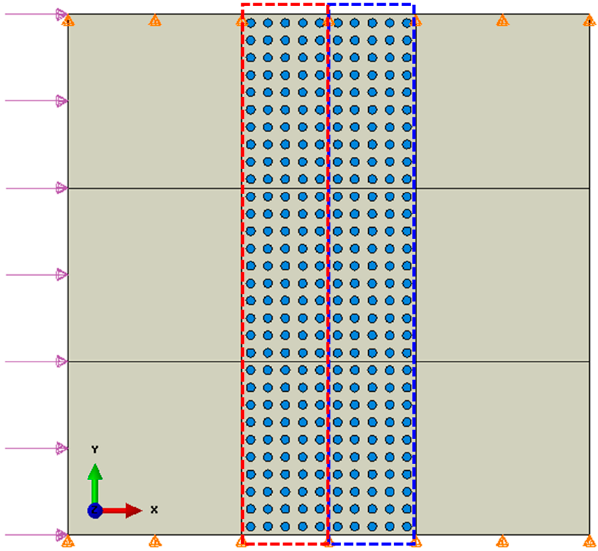
Figure 10. Numerical model of the composite with two different local natural frequencies: 𝑓 (cid:2868) (cid:3406) f 0 ≈ 0.3 MHz for the particles in the red rectangular box and f 0 ≈ 0.6 MHz for the particles in 0.3 MHz for the particles in the red rectangular box and 𝑓 the blue rectangular rectangular box.